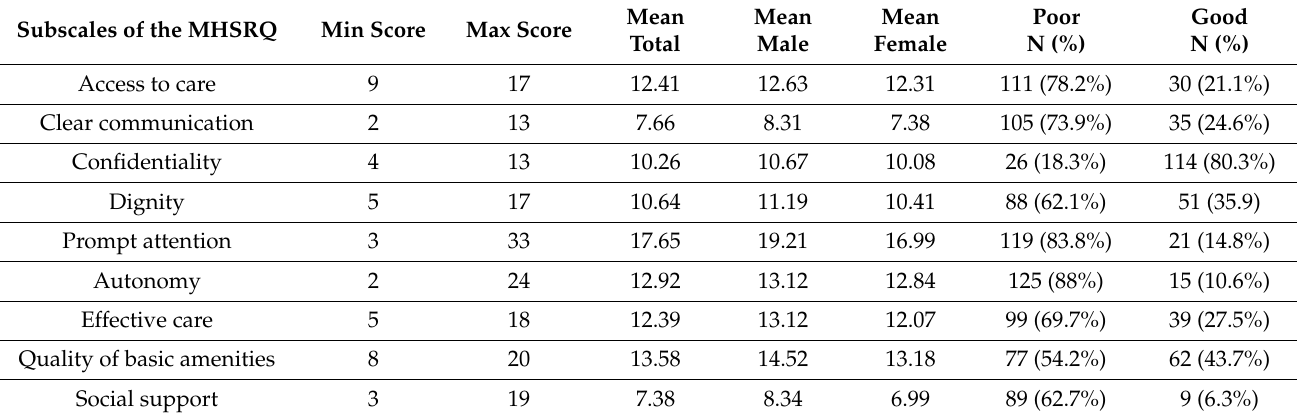
Table 2. Descriptive statistics of subscales of the Mental Health System Response